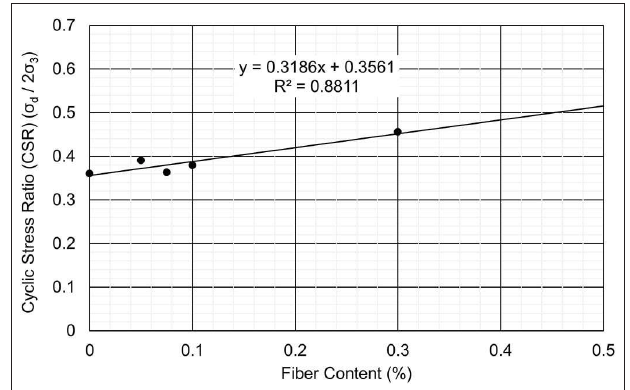
FIGURE 6 | Variation of liquefaction resistance (5% DA deformation at N = 10) of sand with fiber contents at effective confining pressures of 34.48